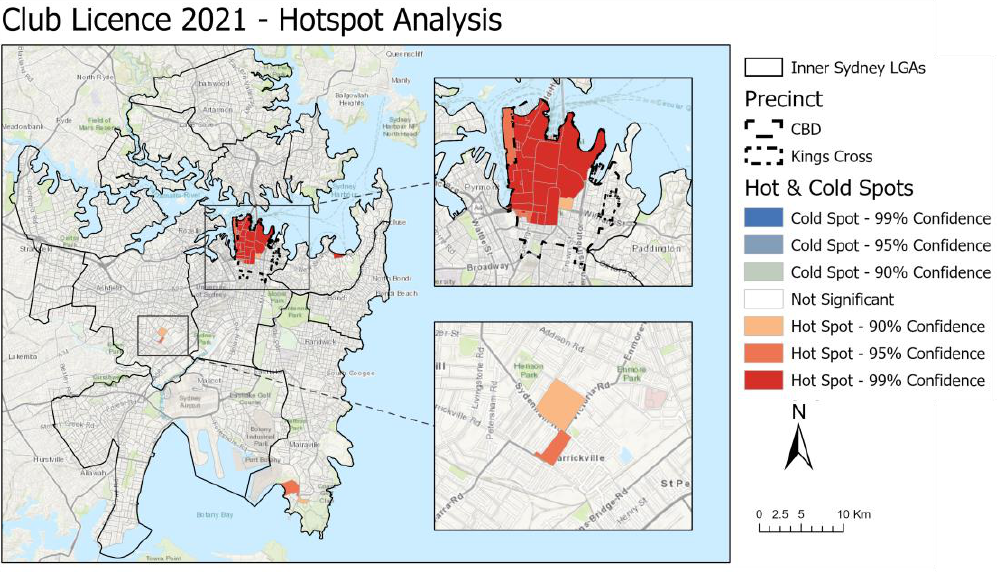
Figure 8. Licensed club hotspots 2021.